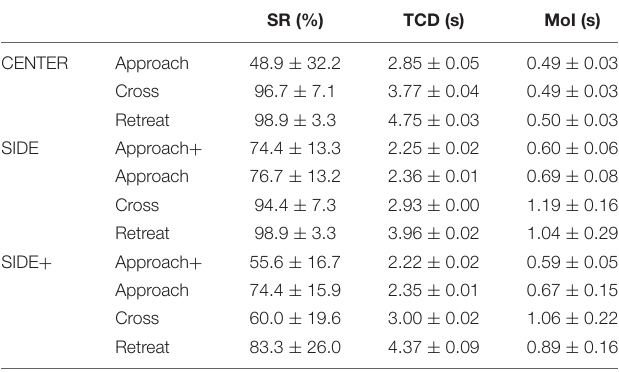
TABLE 1 | Means and between-participant standard deviations ( M ± SD ) of Success Rate (SR), Time until Closest Distance (TCD), and Moment of Initiation